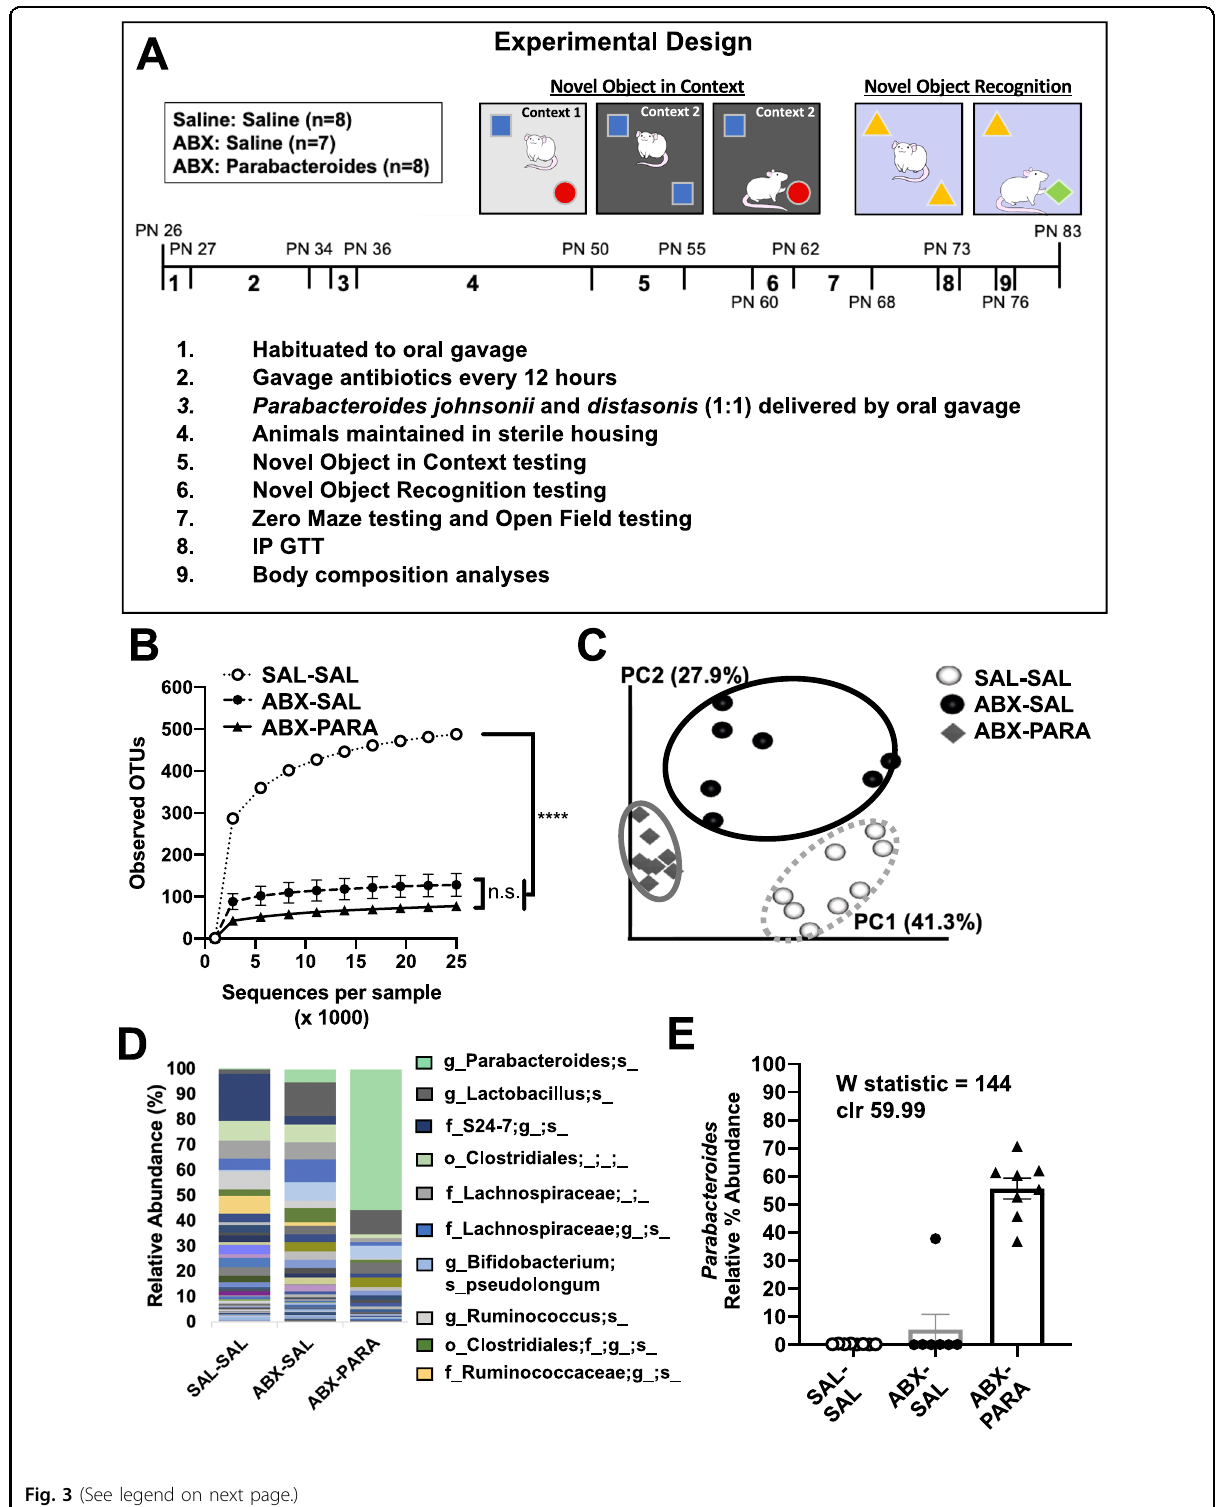
Fig. 3 (See legend on next